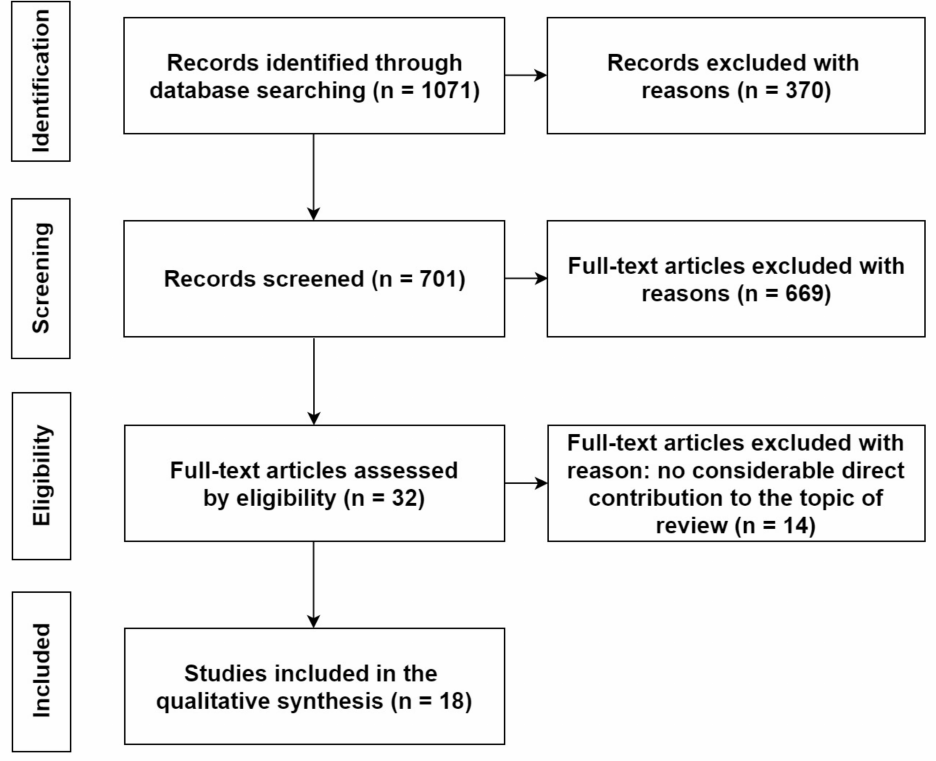
Figure 1. Research design (developed by authors according to Preferred Reporting Items for System- atic Reviews and Meta-Analyses (PRISMA) statement